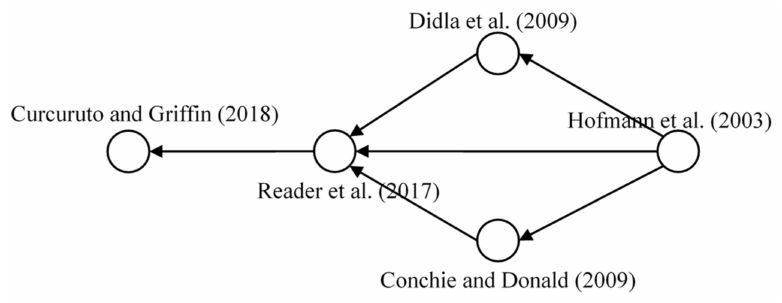
Figure 7. Main path of safety citizenship behavior.